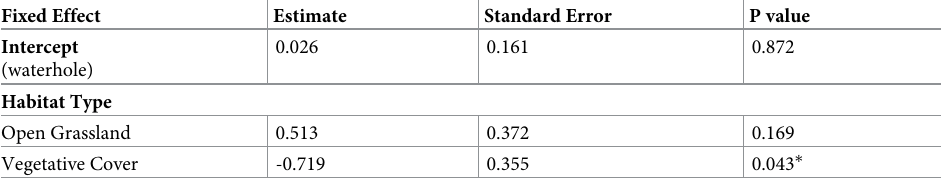
Table 10. Coefficients and P values for the final analysis on how habitat type influenced the formation of mixed- species groups in the wild (N =